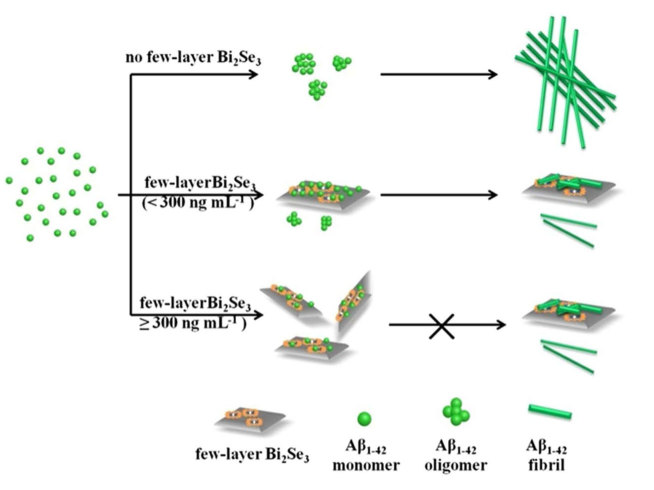
Inhibiting Aβ1-42 fibril formation by few-layer Bi2Se3. Schematic of the mechanism by which few-layer Bi2Se3 may inhibit Aβ1-42 fibril formation.